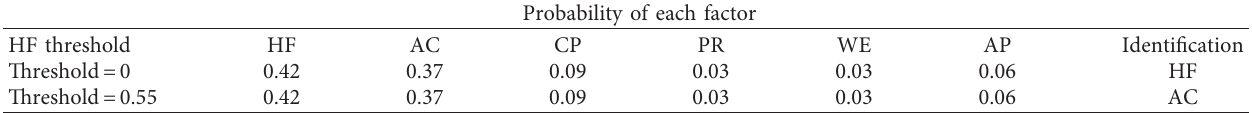
Table 7: An example of how the “HF threshold” affects the identification result. Probability of each factor